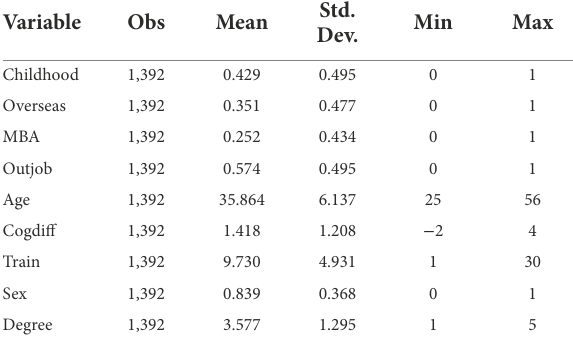
TABLE 8 Descriptive statistics of variables for heirs’ individual